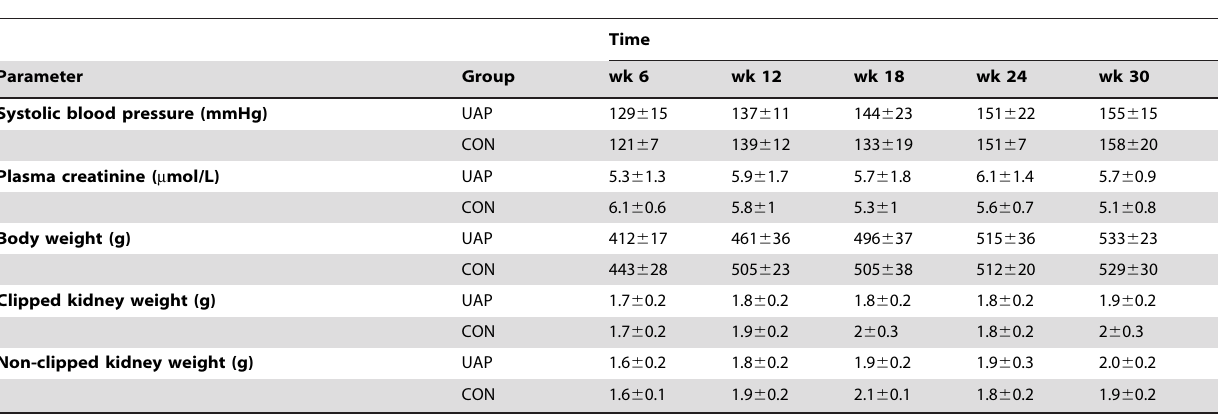
Table 1. Group characteristics from the experimental